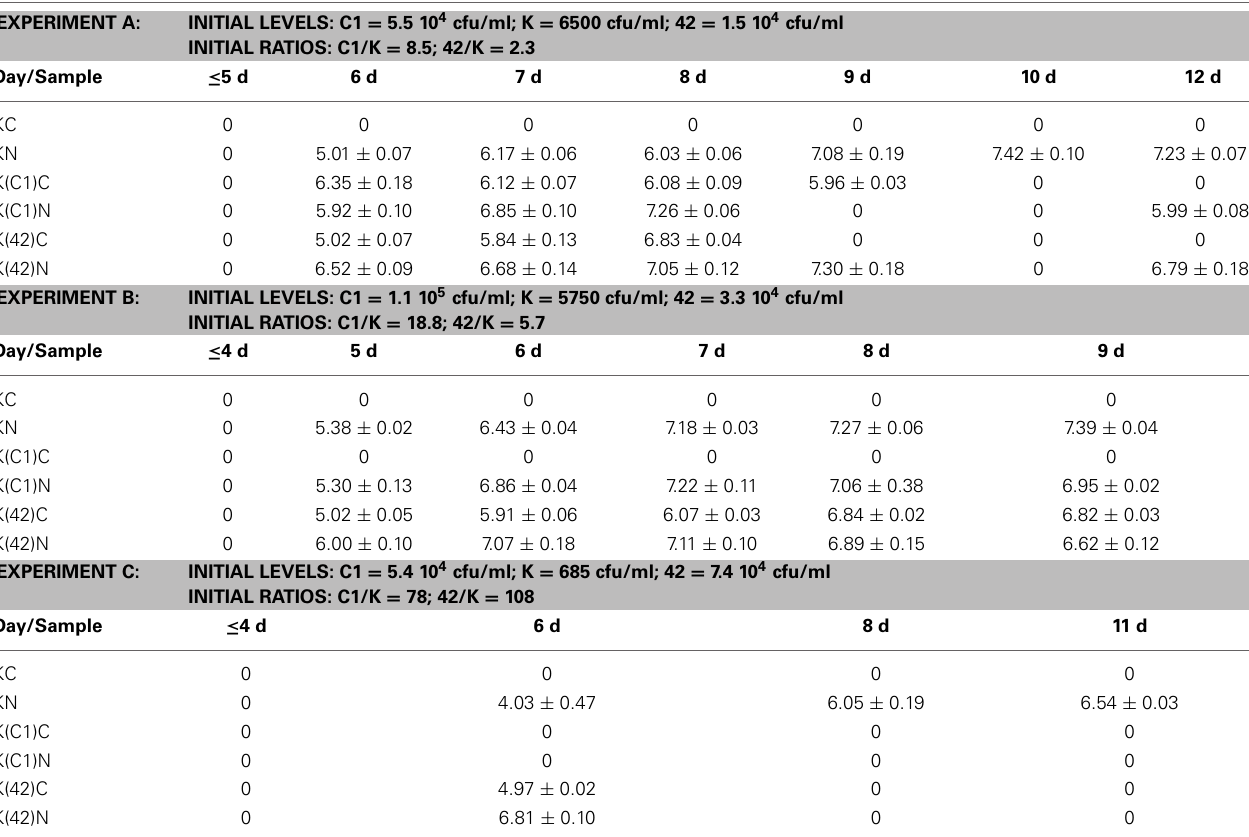
Table 1 | Small colony variants as log cfu/ml that were enumerated from monocultures of B. weihenstephanensis KBAB4 (K) or from co-cultures with the Pseudomonas raw milk isolate C1 (C1) or with P. tolaasii LMG 2342 T (42) at 15 ◦ C in BHI broth. EXPERIMENT